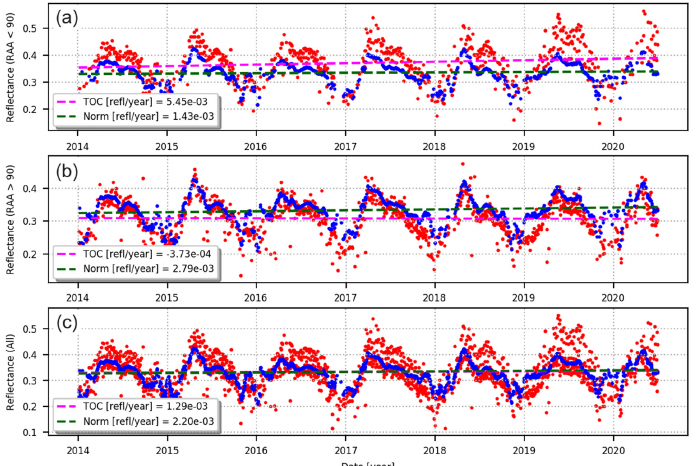
Figure 8. The figure shows TOC reflectance in NIR band for a cropland site (Belmanip-232) located in Barrax, Spain (lat/lon = 39.06°/ − 2.07°). The plots present the temporal series of TOC (red) and BRDF-normalized (blue) reflectances for three angular conditions: ( a ): RAA < 90°, ( b ) RAA > 90°, ( c ): “All”; the latter corresponds to retaining all observations in the fit. The fitted linear curves are also shown for TOC (purple) and BRDF-normalized (green) data with drift values reported in the legend. In the plot ( c ), the two regression lines lies above each other. The temporal series of NIR reflectances over a dry shrubland site, located in the north of Mexico (lat/lon = 27.57°/ − 103.61°) (see Figure 9) confirms the previously observed asym- metry in the estimated drift for backward and forward scattering conditions. The spurious positive drift in the backscattering is particularly evident over this site, with maxima of NIR reflectances increasing by up to 15% in mid-2020 as compared to the values at the beginning of the mission. In the opposite direction, the decrease is also evident. When all observations are merged, the opposite drifts in the two angular conditions—0.0042 and − 0.0018 re fl ectance/year, respectively—largely cancel out, with a resulting drift of 0.000049 reflectance/year. The BRDF normalization procedure dramatically reduces the day-to-day and seasonal changes and resolves the azimuthal asymmetry of the estimated drifts, since the drifts in the three angular conditions have now the same sign and compa- rable values. The BRDF normalization is particularly efficient over this temporally stable dry shrubland site, since the fluctuations in NIR reflectances induced by SZA seasonal and inter-annual changes are largely smoothed out. Yet, some localized anomalies are ob- served in the BRDF-normalized time series, such as a minimum during winter 2015 and a maximum during summer 2017. These localized anomalies do not impact the drift esti- mation, as confirmed by the plotted fitted line, following the slowly varying temporal changes of reflectances along the mission lifetime.